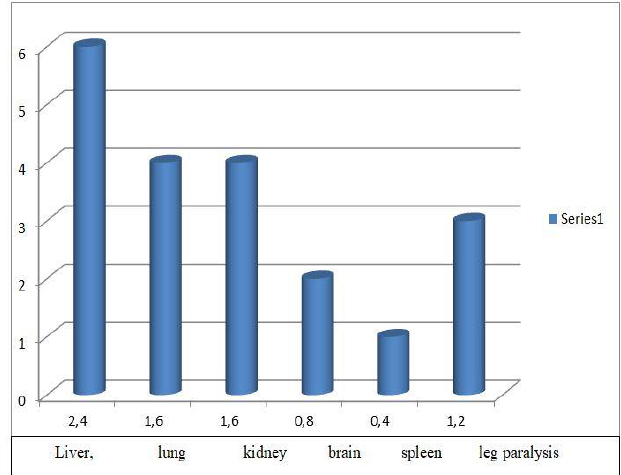
Fig.1: Showed the affected visceral organs with prevalence of it.